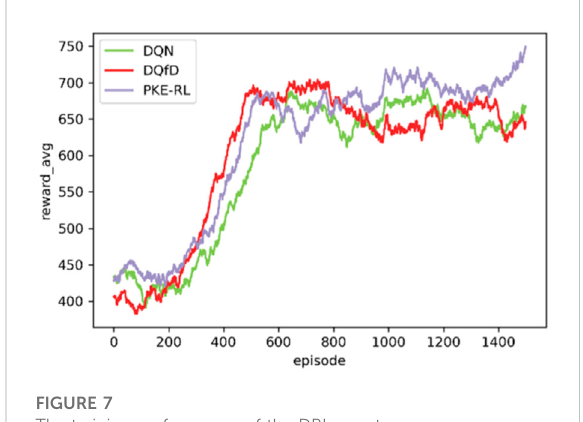
FIGURE 7 The training performance of the DRL agents.